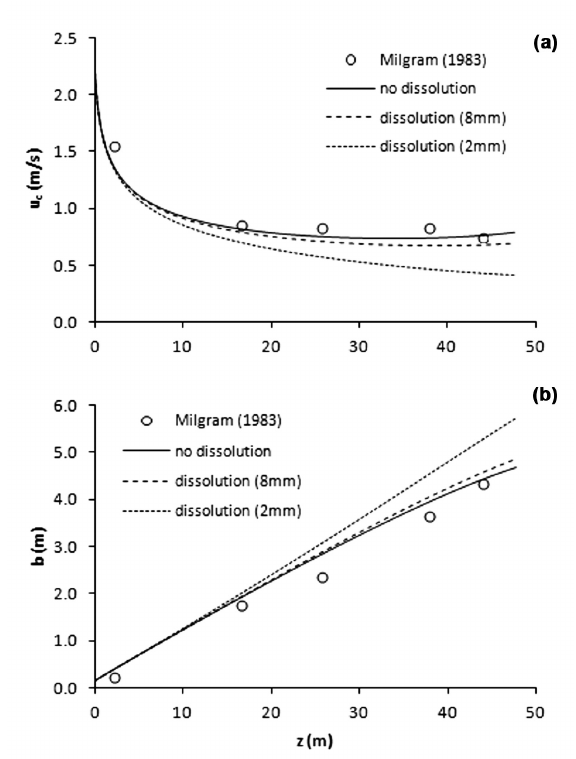
Figure 2 - Comparison between model predictions and experimental data of Milgram (1983) for Q = 0.118 m 3 /s and g,a H = 50 m: (a) centerline liquid velocity, and (b) plume radius. d Simulations are performed for β = 1.91, α = 0.097 and γ = 1.25, and under three conditions: no dissolution, and dissolution of air bubbles with diameters d of 2 and 8 b